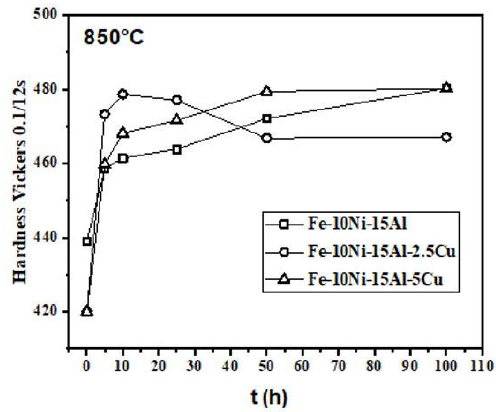
Figure 13. Aging curves for the Fe-10at.%Ni-15at.%Al, Fe-10at.%Ni- 15at.%Al-2.5at.%Cu and Fe-10at.%Ni-15at.%Al-5at.%Cu alloys aged at 850